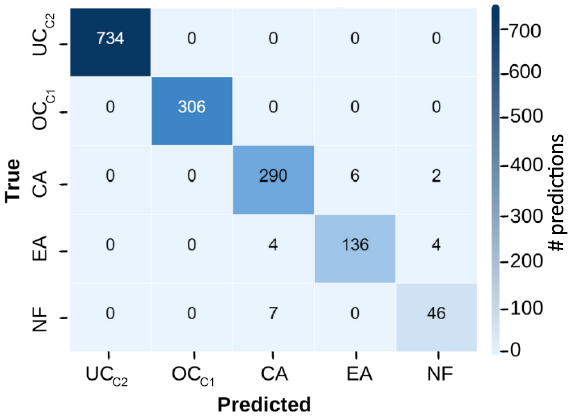
Fig. 7 Confusion matrix for Method 3 without normalization.